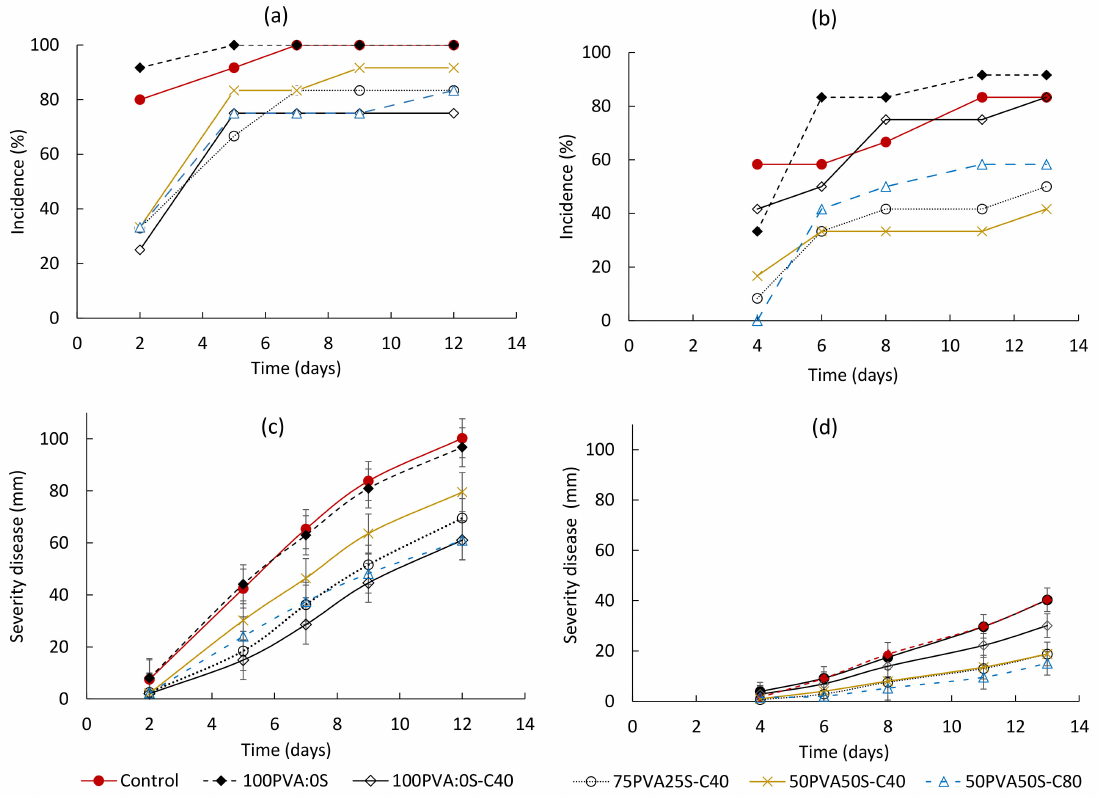
Figure 2. Incidence (%) and severity disease (mm) in apple inoculated with ( a , c ) Botrytis cinerea and ( b , d ) Penicillium expansum throughout the incubation